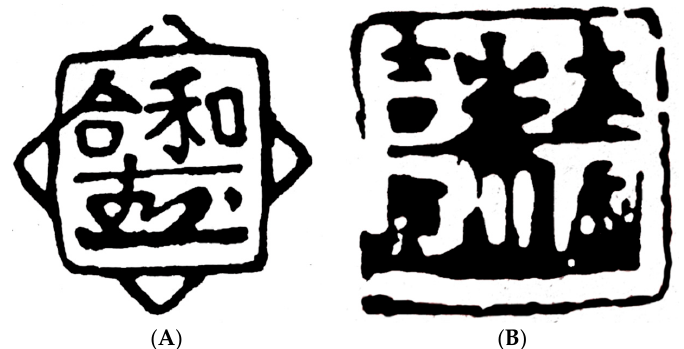
Figure 30. ( A ) A Song Yuan Huaya carved with an ethnic character and an auspicious idiom. The period of the Song and Yuan Dynasties. Inventory number: 1689. Sketched by author. Picture source: Wen (1995), p. 402. ( B ) A Song Yuan Huaya carved with an ethnic character and an auspicious idiom. The period of the Song and Yuan Dynasties. Sketched by author. Picture source: Shi (1995), p. 54.